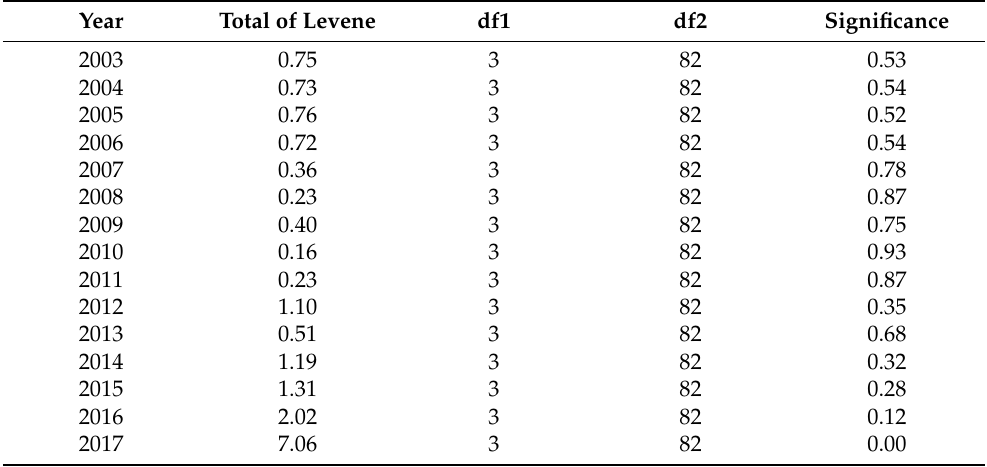
Table A1. Homogeneity test results of variance between areas and non-areas in Guizhou province.